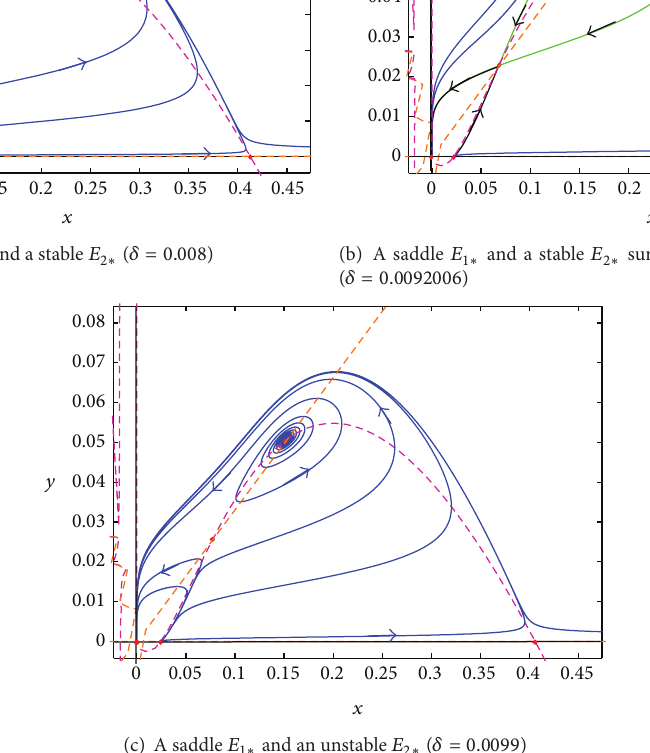
Figure 2: Phase portraits of system (7) if 𝛼 > 𝛼 1 and for 𝑔 = 1.44 , 𝛼 = 0.8 , 𝛼 1 = 0.4 , and 𝛽 = 0.3